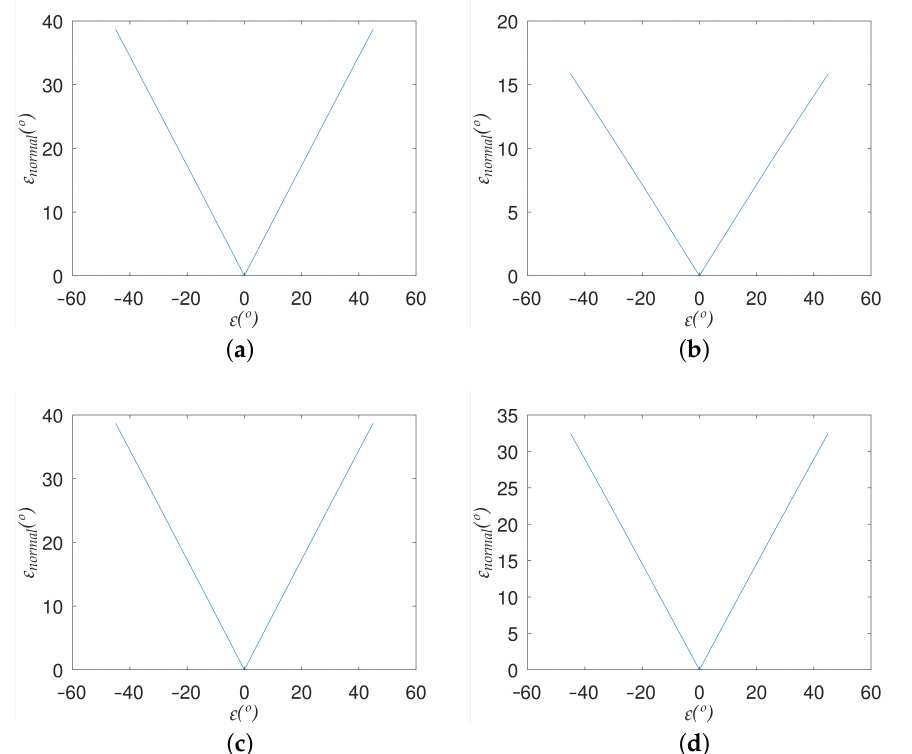
Figure 4. Deviation between the normals of the ideal and calculated planes as a function of the error in angle θ for: ( a ) Plane 1, ( b ) Plane 2, ( c ) Plane 3, ( d ) Plane 4.